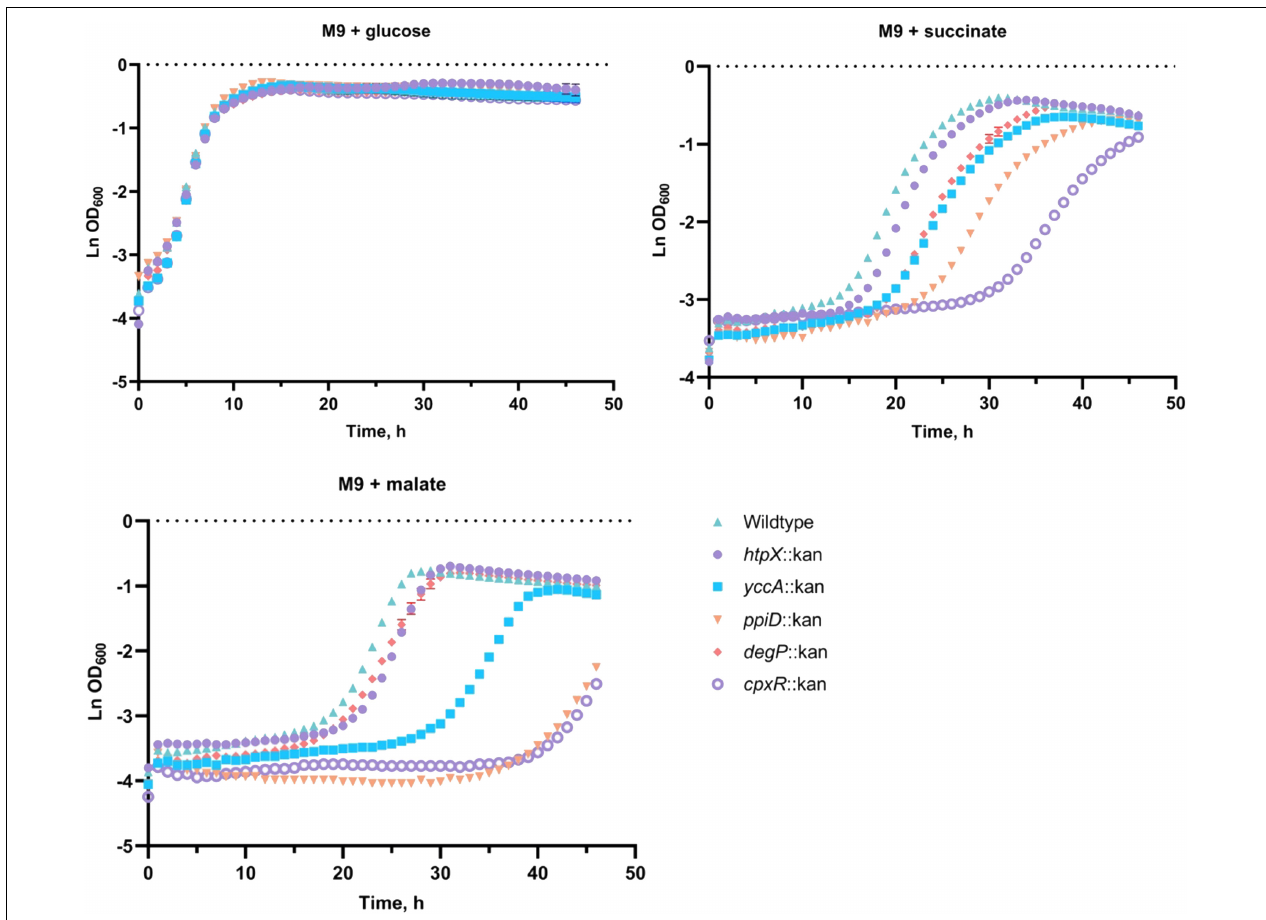
FIGURE 5 | Deletion of several Cpx-regulated protein-folding and degrading factors results in growth defects in minimal media. Wildtype BW25113 and the mutants carrying the indicated gene deletions were grown overnight in LB at 37 ◦ C, washed twice in 1x phosphate-buffered saline (PBS), and standardized to an OD 600 of 1.0 in phosphate buffered saline. 10 µ L of the culture was subcultured into M9 minimal medium containing 0.4% glucose, 0.4% malic acid, pH 7.0 (malate) or 0.4% succinic acid, pH 7.0 (succinate), and grown for 48 h at 37 ◦ C with 330 rpm linear shaking. Data correspond to the mean values from three biological replicates and are representative of three independent experiments. Error bars depict standard deviations